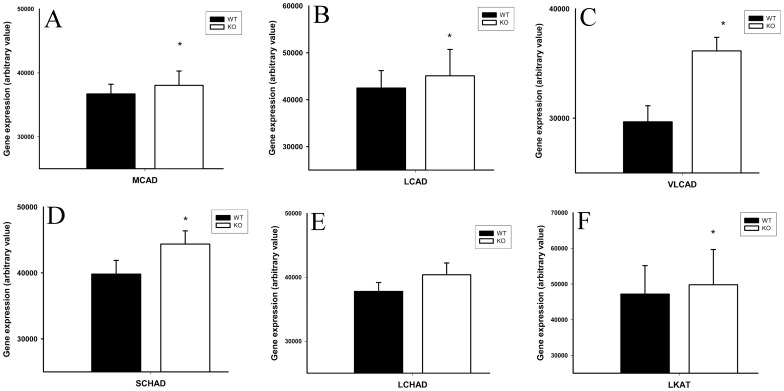
Composite image of semi-quantitative RT-PCR (densitometry) in small intestine mucosal scrapings for MCAD, LCAD, VLCAD, SCHAD, LCHAD and LKAT (Panel A to F) expression in 1-week-old OCTN2+/+ (black bar) and OCTN2−/− mouse (white bar) respectively.Expression of HPRT was used to normalize data from each group. Asterisks (*) represents a statistically significant change in expression.